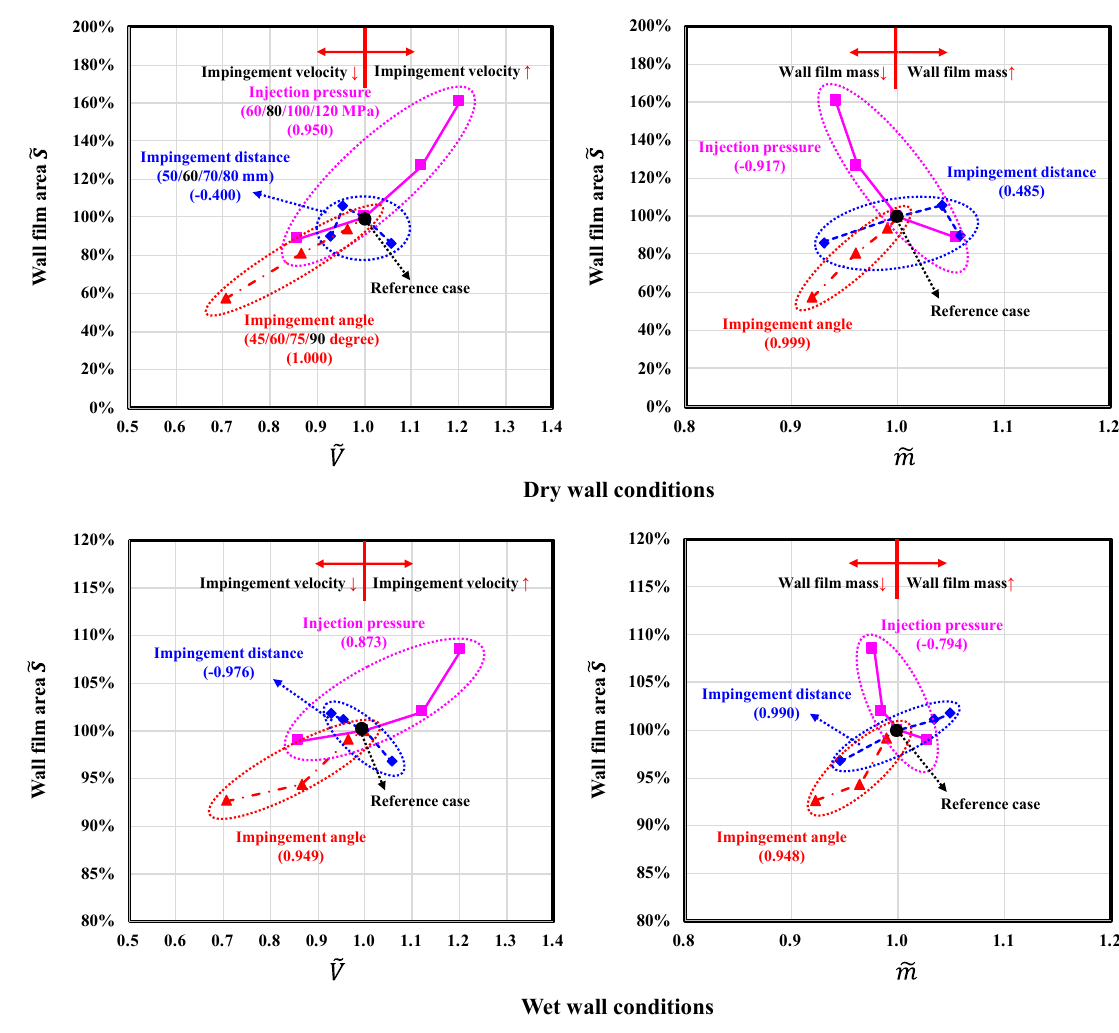
Figure 10. Relationships between wall film area and dimensionless number (cid:101) V and (cid:101) m